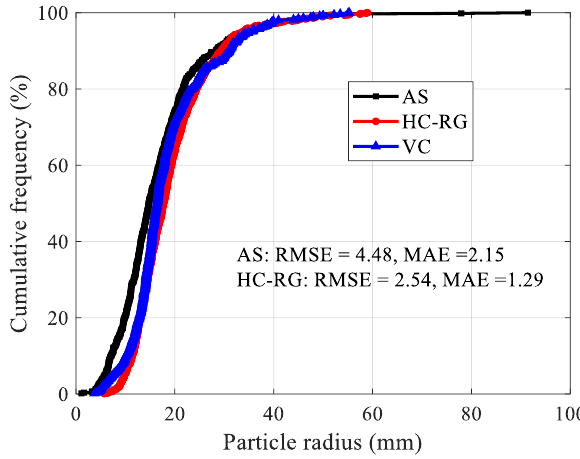
Figure 9. Particle radius distribution of pebbles.